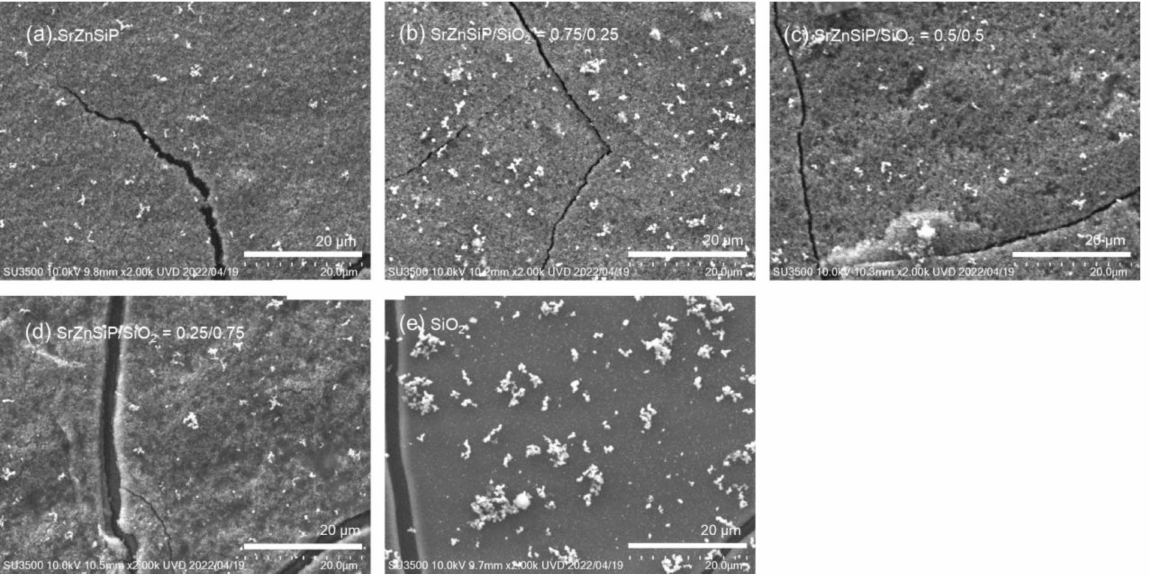
Figure 12. SEM observation of the CaP deposition on the UHMWPE disk coated with ( a ) SrZnSiP; ( b ) mixture of SrZnSiP and SiO 2 (0.75/0.25); ( c ) mixture of SrZnSiP and SiO 2 (0.5/0.5); ( d ) mixture of SrZnSiP and SiO 2 (0.25/0.75); and ( e ) SiO 2 after soaking in SBF. Magnification 2 ×